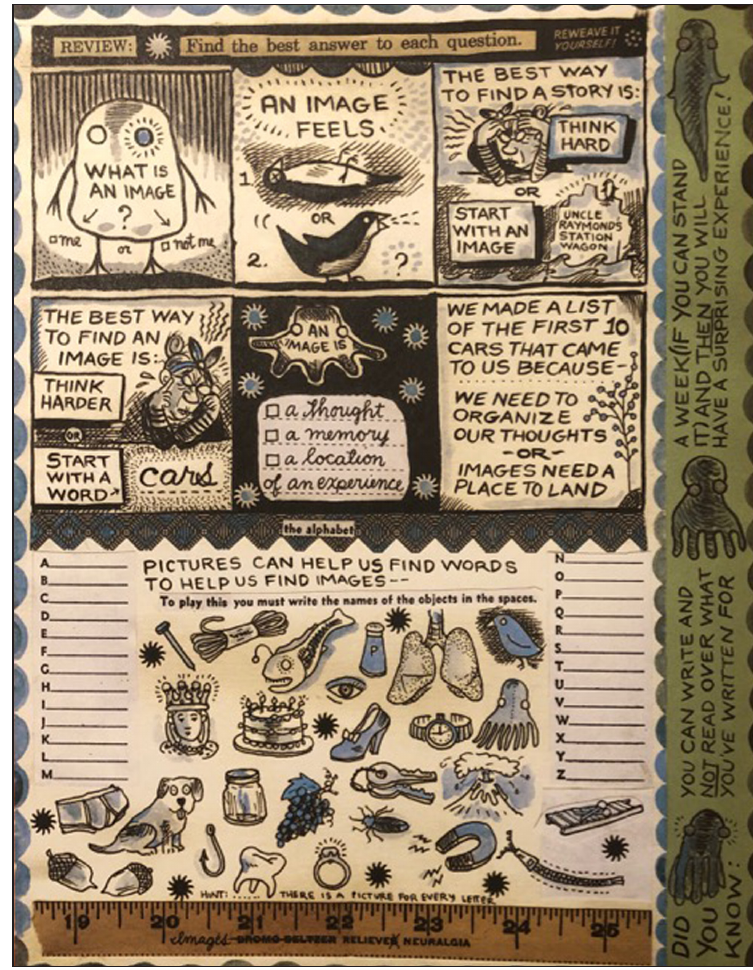
Figure 1: Lynda Barry (2008) What It Is. Montreal: Drawn & Quarterly. © Lynda